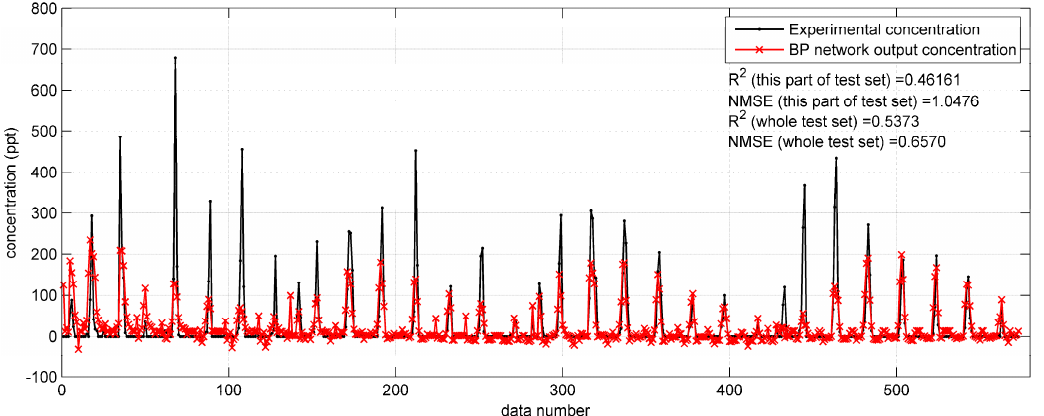
Figure 5. The prediction results of BP network with integrated Gaussian parameters on the data from 11:00 a.m. to 2:00 p.m. on 17 September (a part of the test set) in the Indianapolis case.